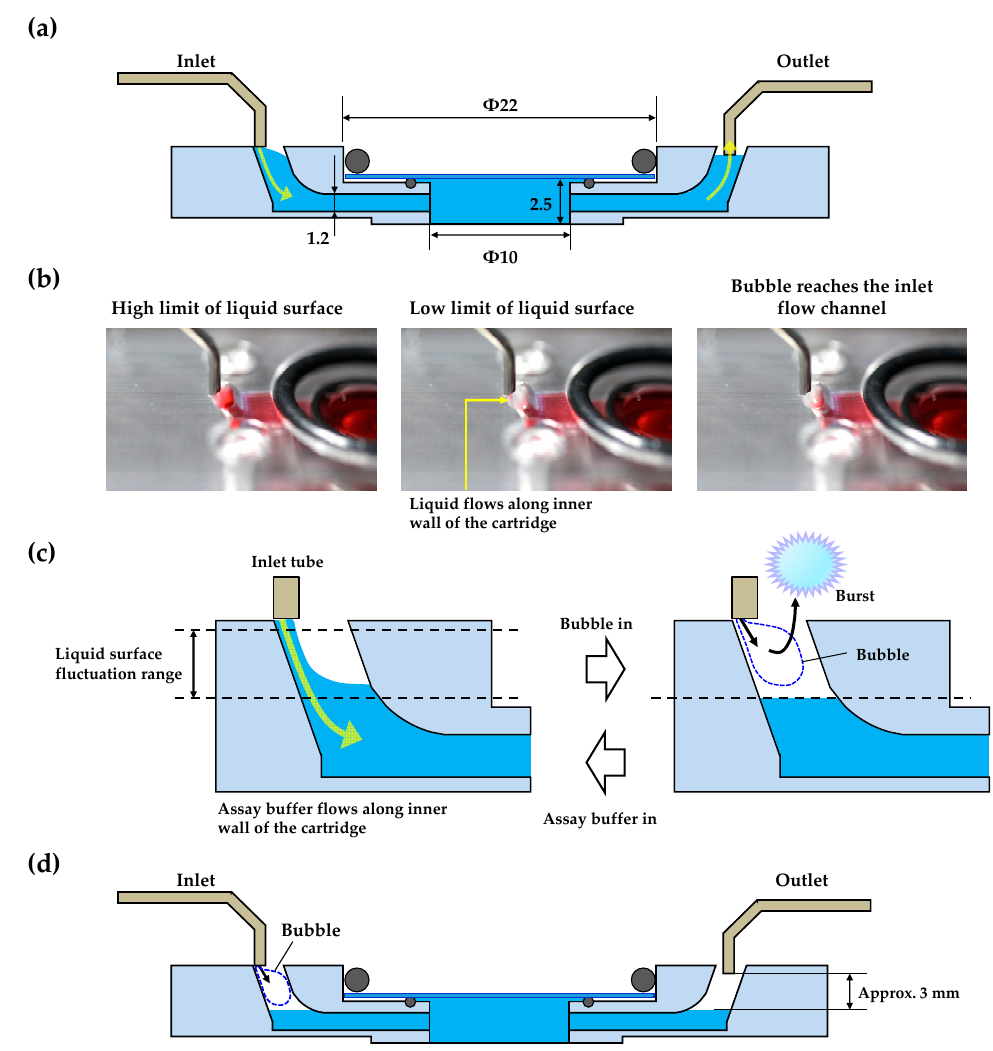
Figure 2. ( a ) Schematic of cross-sectional view of the assembled top-layer of the 3D-printed cartridge with metal tubes during perfusion; ( b ) images of the liquid surface level; ( c ) schematic of the bubble removal mechanism of the top-layer of the 3D-printed cartridge; ( d ) schematic of medium retention mechanism of the 3D-printed cartridge.